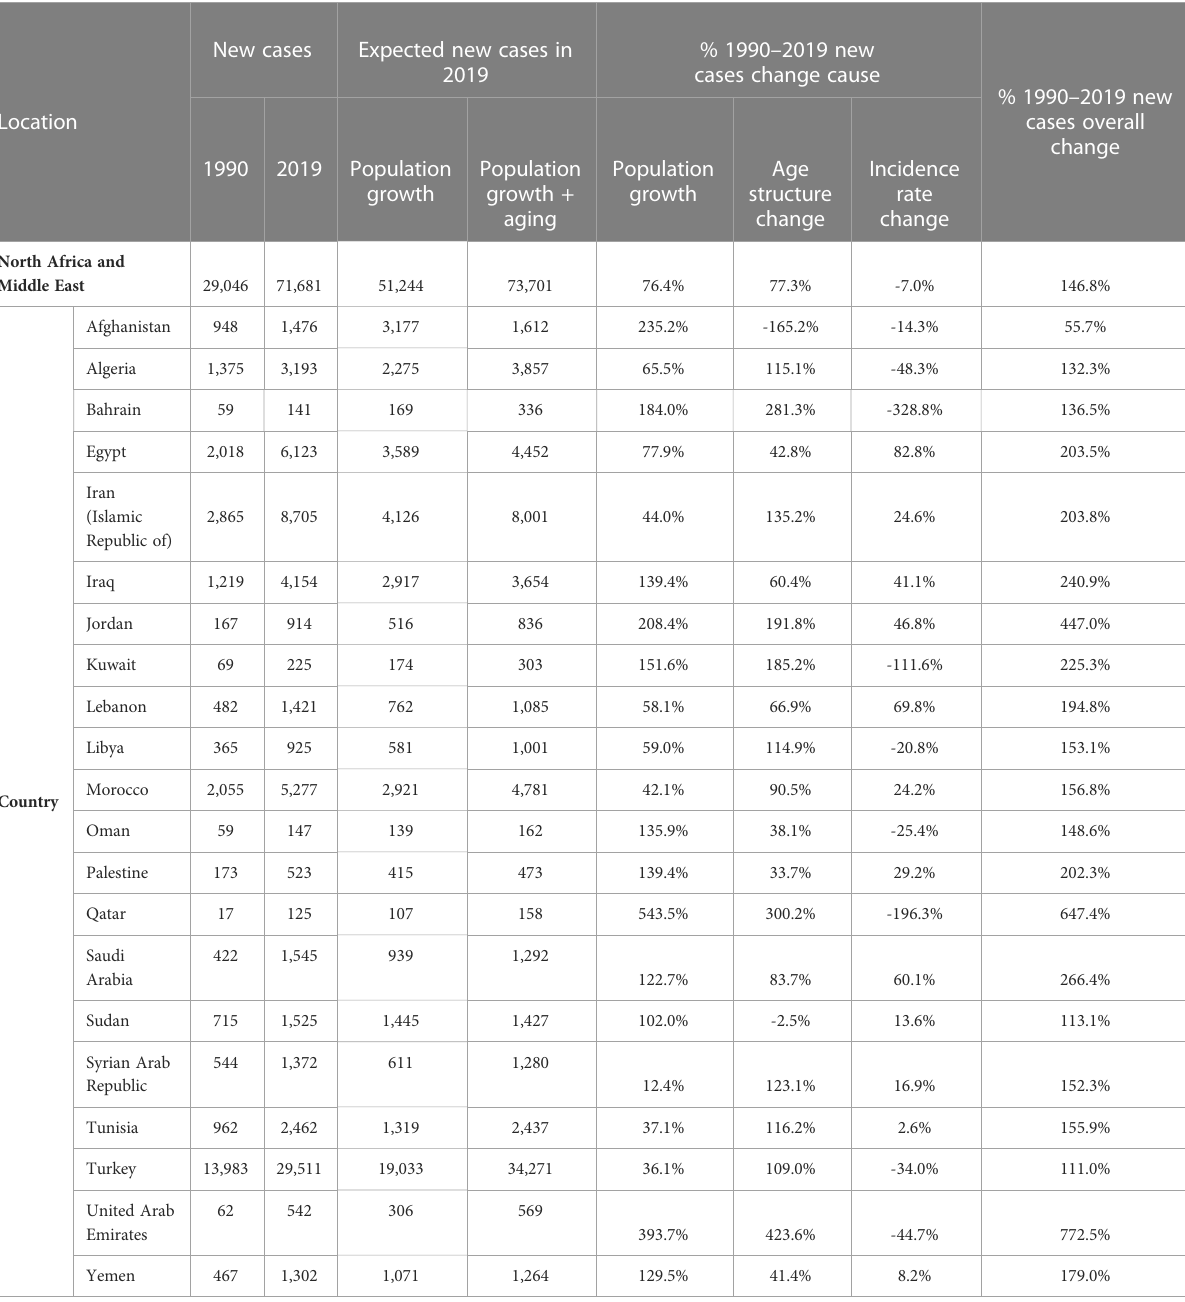
TABLE 2 Decomposition analysis of new cases change cause between 1990 and